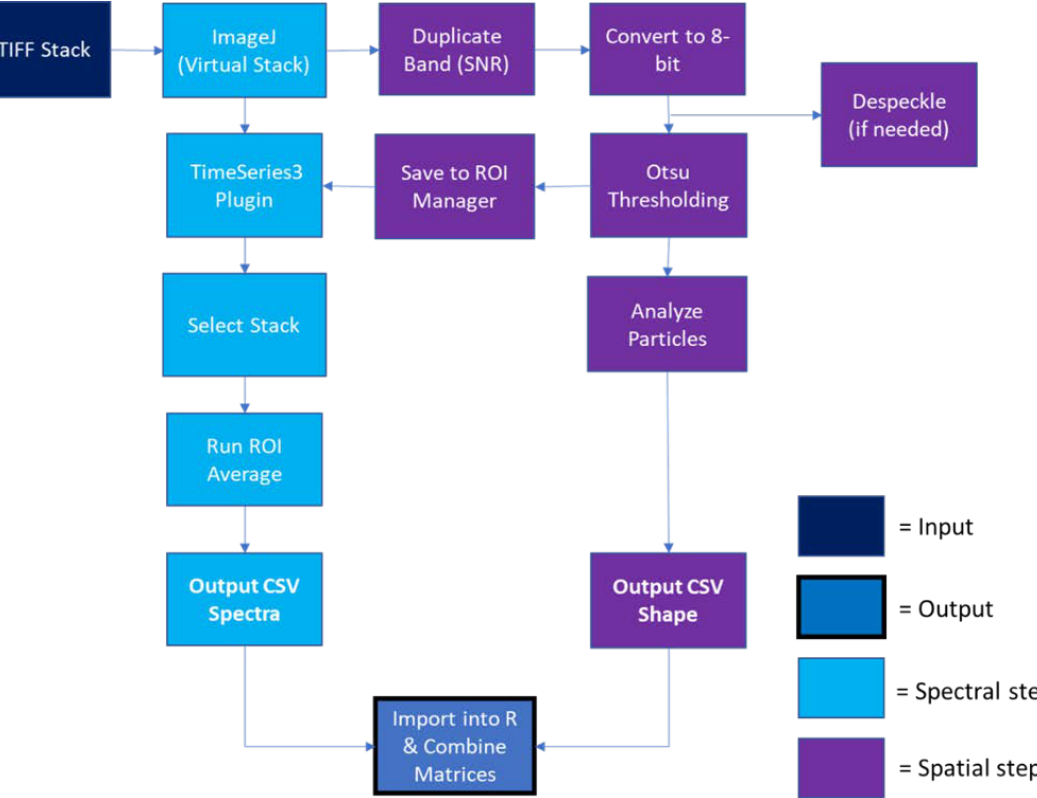
Figure 1. Flowchart of steps used to record Fiji macro for processing hyperspectral microscope images of bacteria.